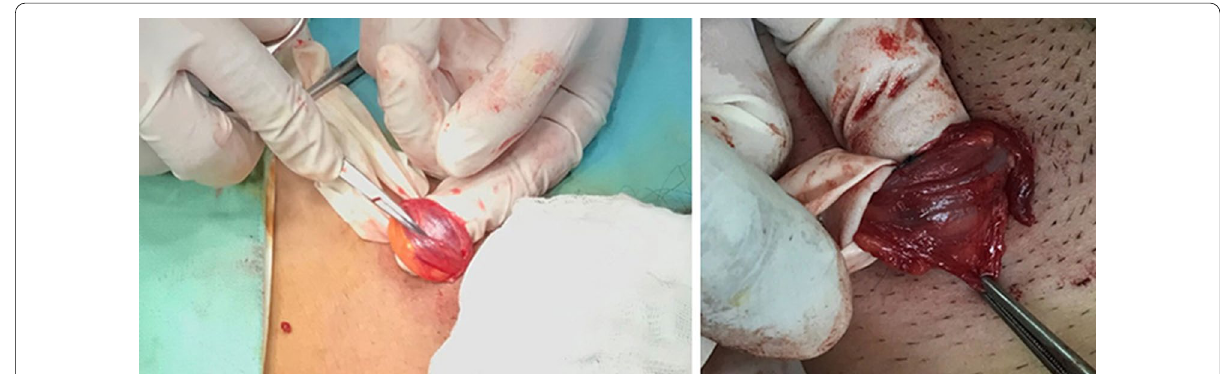
Fig. 3 The spermatic cord has been dissected through the inguinal skin incision